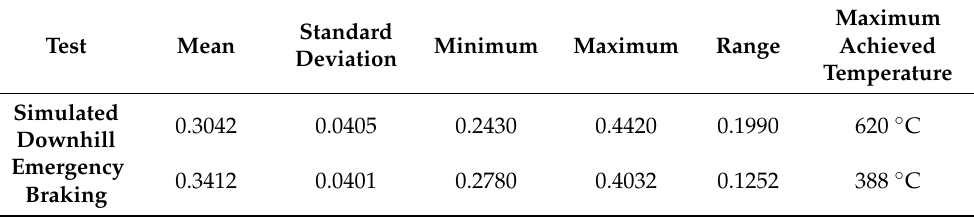
Table 2. Descriptive statistics of the experiments—response variable coefficient of friction.